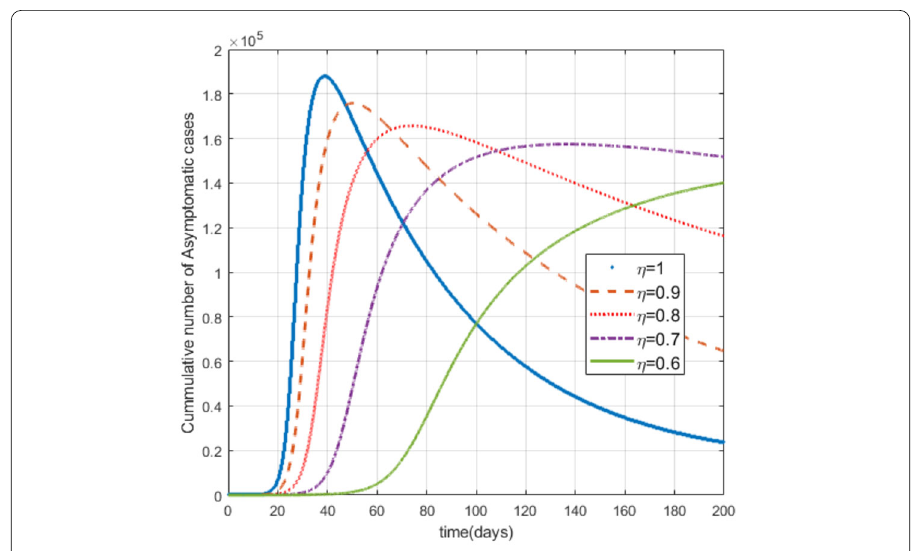
Figure 4 Total number of asymptomatic cases (A) for different values of η